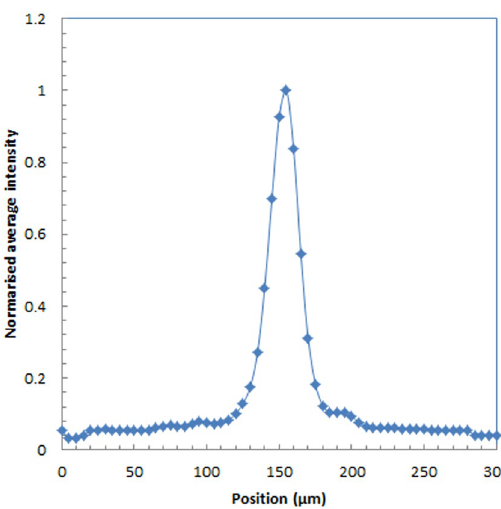
Figure 7. Intensity profile of alpha particle for 512 × 512